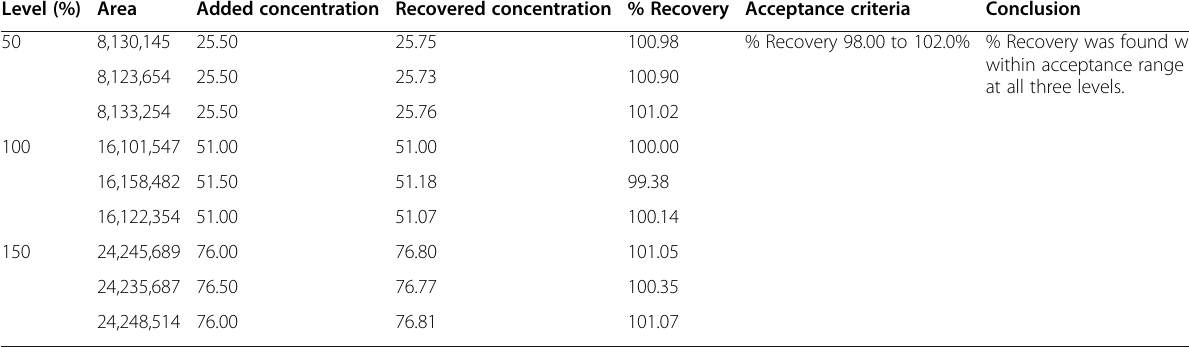
Table 11 Result and statistical data of accuracy